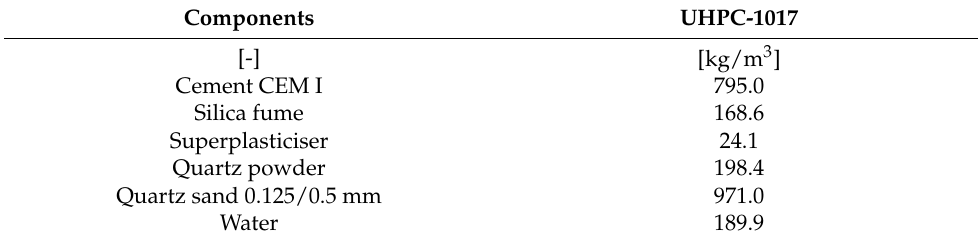
Table 5. Mix proportions of the used plain